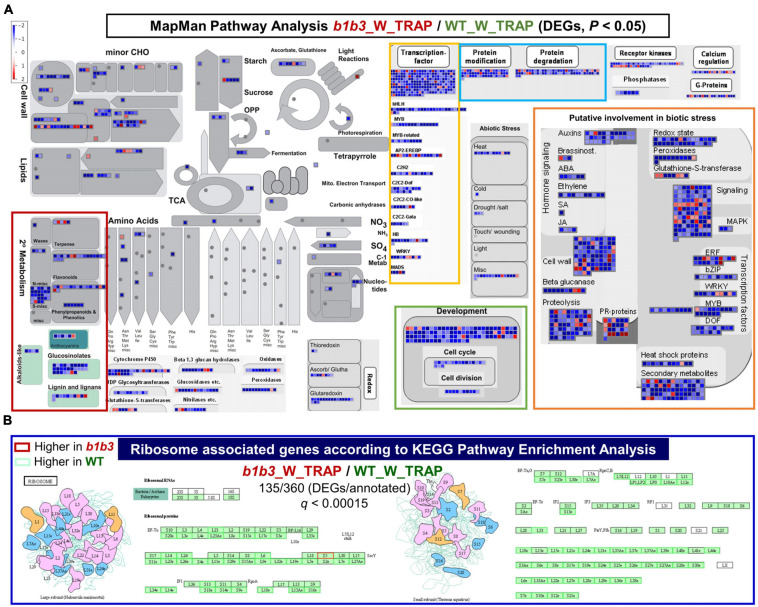
Pathway analysis of differentially expressed TRAP transcripts in wounded WT and b1b3. (A) MapMan pathways analysis of the b1b3_W_TRAP/WT_W_TRAP comparisons. All transcripts included in the figure met the P value cutoff (P < 0.05) and the FC cutoff (log2FC ≤ −1 and ≥ 1). Each colored square is representative of a single gene, and the color indicates either up- or down-regulation with scales from red to blue as shown in the key. (B) Ribosome-associated genes found to be most significantly (q < 0.00015) overrepresented in the b1b3_W_TRAP/WT_W_TRAP comparisons according to the KEGG Pathway Enrichment Analysis. Red and green boxes indicate higher and lower, respectively, expression in b1b3 compared to WT. Cartoons represent large and small ribosomal protein complexes.